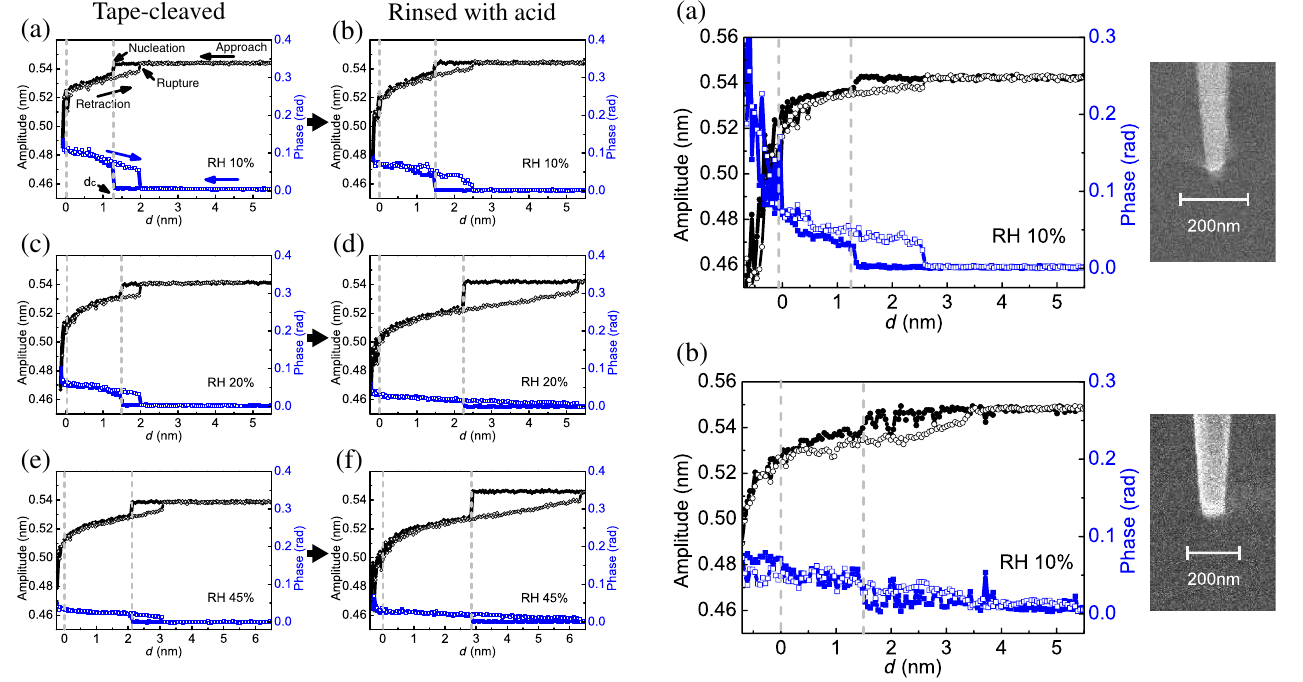
FIG. 11. Fluctuating amplitude and phase signals due to the rough-end tip during its contact with the substrate and subsequent retraction. Panels (a) and (b) represent separate experiments using different rough tips. Both experiments were conducted at RH 10%. The SEM image of the tip is shown on the right side of each panel. The results indicate that the roughness of the tip apex is indeed reflected on the enhanced fluctuations in the approach- retraction curves, and the fact that we have obtained clean approach-retraction curves suggests that the tip apex was not rough for our